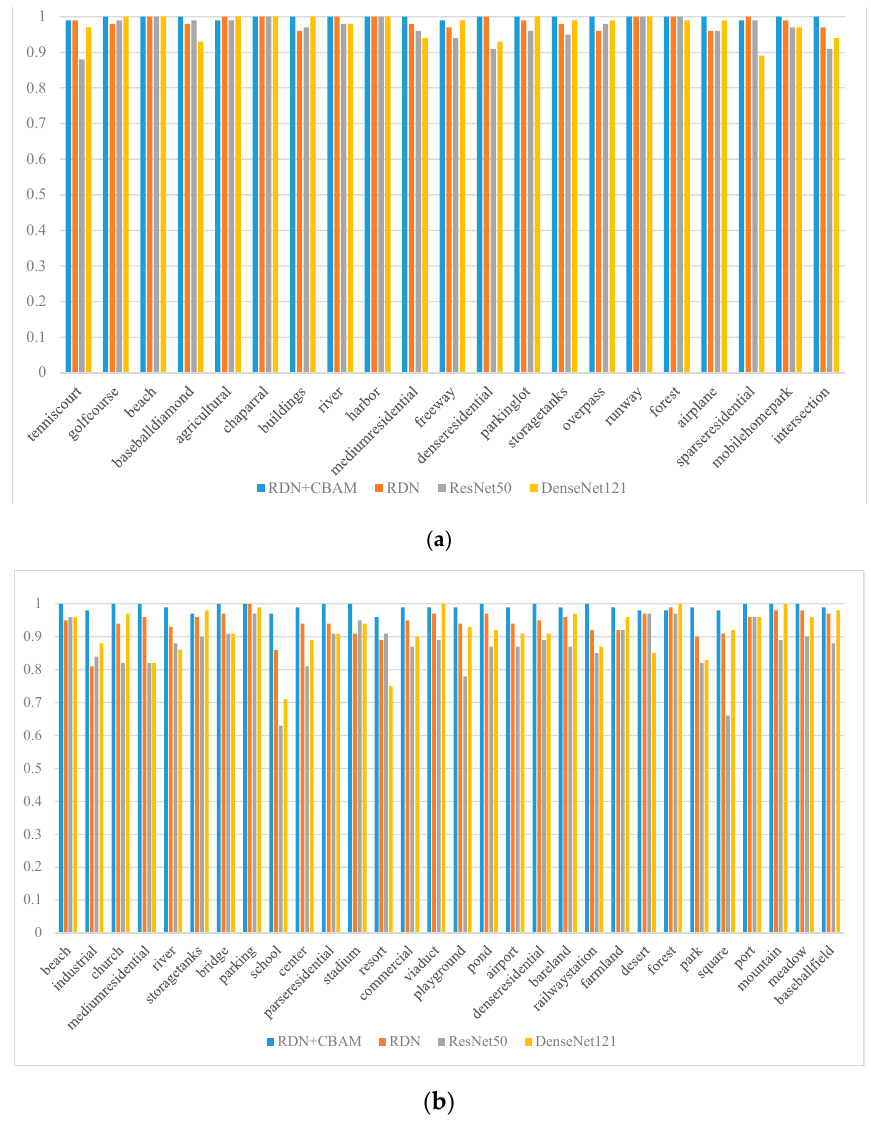
Figure 8. Classification accuracy in each category of RDN + CBAM, RDN, ResNet50, DenseNet121 on UCM and AID: ( a ) UCM dataset; ( b ) AID dataset. Table 3. Classification accuracy in each category of RDN + CBAM, RDN, ResNet50, DenseNet121 on the UCM dataset.